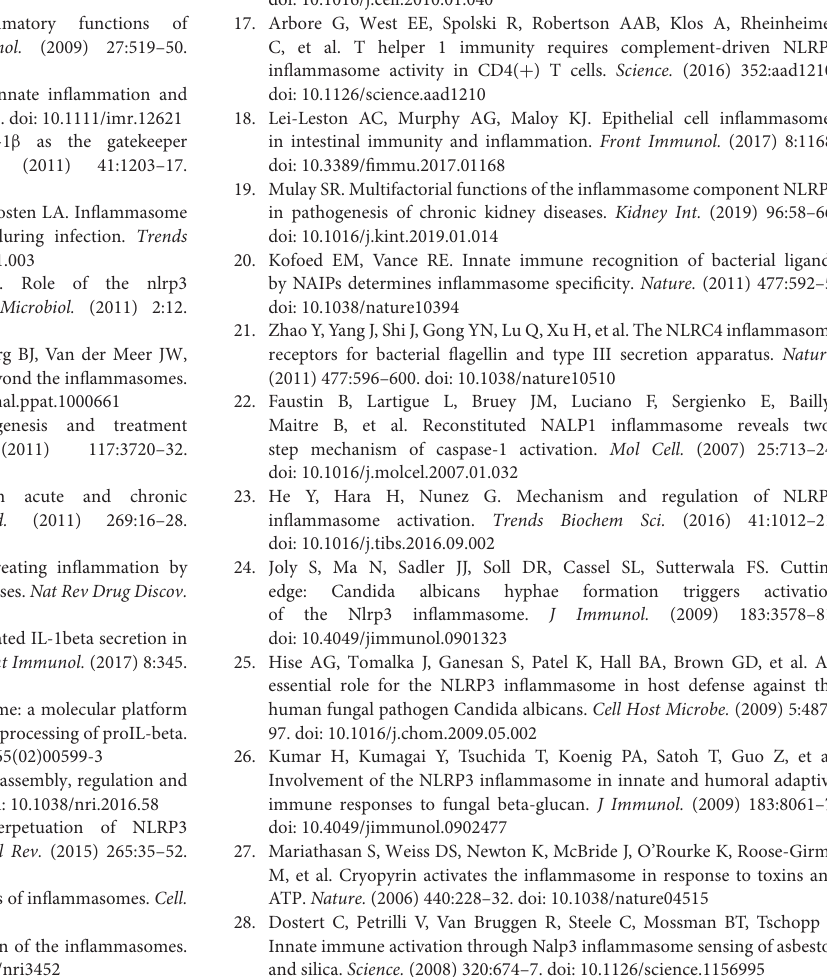
Images from rotation of aligned models on the X- and Y- axis with respective degree of rotation on individual axes (bottom). Figure S4 | Human NLPR3 does not substitute for mouse NLRP3. (A) IL-1 β production by WT, mNlrp3-/-, or human NLRP3 expressing mNlrp3-/- immortalized mouse macrophages after stimulation with LPS (100ng/ml; 4h) and 5 µ M nigericin (2h). Inset: Western blot for NLRP3 in the indicated cells. Data represent the mean ± SD for two independent experiments. (B) IL-1 β production by HEK293T cells expressing human ASC, Caspase-1, and IL-1 β and the indicated human or mouse NLRPs were infected with Fn U112 (MOI = 50). Mean ± SD are shown from one preliminary experiment. (C) IL-1 β production by WT, mNlrp3-/-, or human NLRP3 expressing mNlrp3-/- immortalized mouse macrophages after stimulation with LPS (100ng/ml; 11h) and 5 µ M nigericin (1h). Data represent the mean ± SD for three independent experiments. (D) Percent cell death for cells in (C) . Mean ± SD for three independent experiments. Figure S5 | Monosodium urate (MSU) display distinct activation requirements. (A) Schematic representation of C-terminal LRR domain and NBD domain truncation mutants. (B) IL-1 β response of HEK293T cells expressing ASC, pro-Caspase-1, pro-IL-1 β , and NLRP3 or the indicated mutants after stimulation with MSU (150 µ g/ml) for 1h. Supernatant IL-1 β was measured by ELISA. Means + / − SEM are shown ( n =